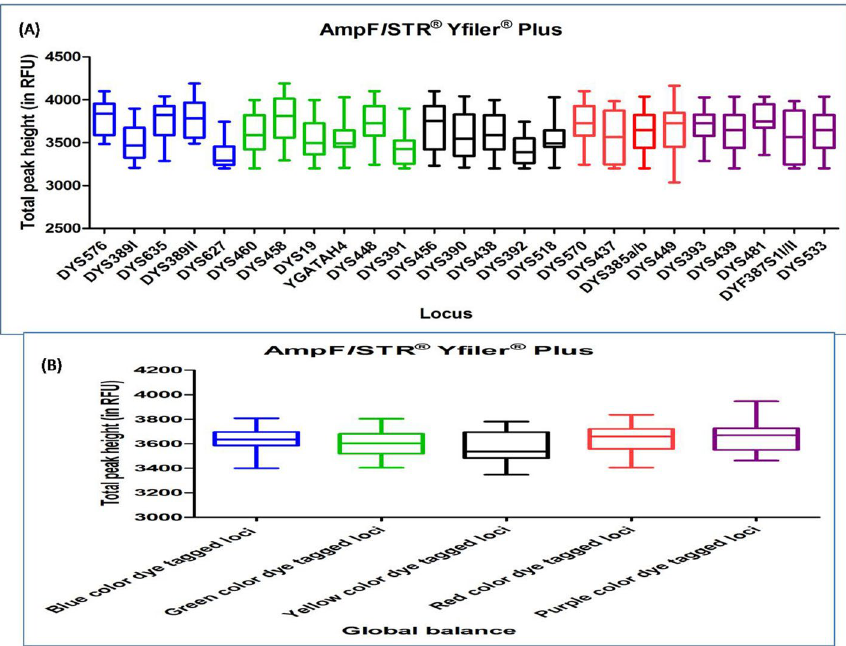
Figure 13. Quality assessment of DNA profile by Dunn’s multiple comparison test for the AMPFLSTR YFILER PLUS PCR AMPLIFICATION KIT ( A ) Total peak height ( B ) Global balance.